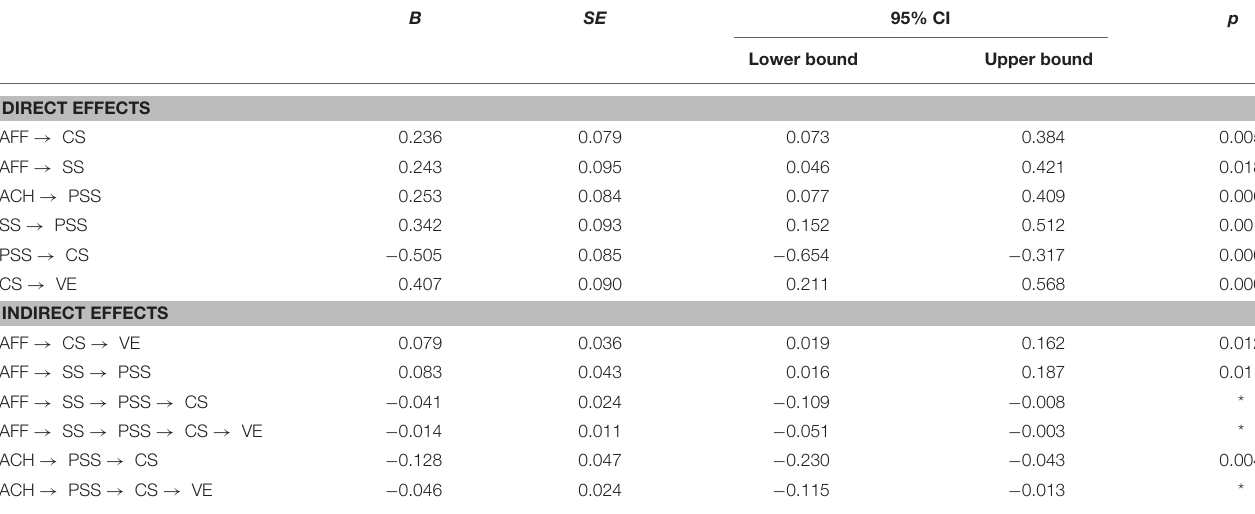
TABLE 3 | Direct and indirect effects and 95% confidence intervals for the overall structural equation model. B SE 95% CI p Lower bound Upper